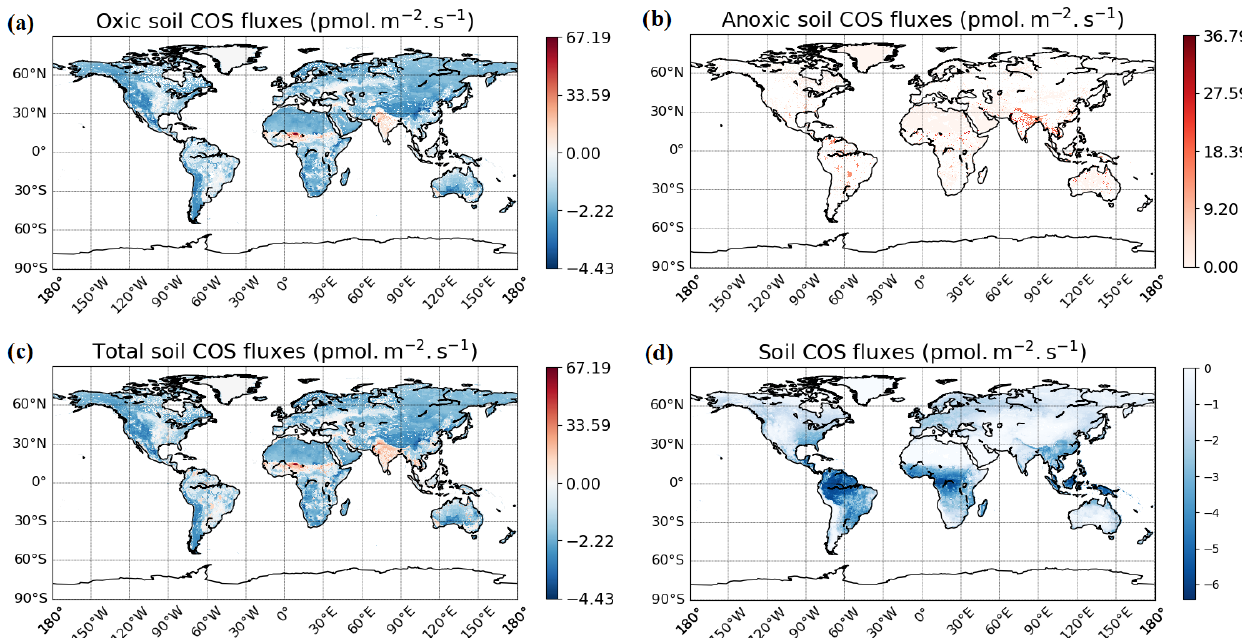
Figure 7. Maps of mean soil COS fluxes for the mechanistic (a, b, c) and the empirical model (d) , computed over 2010–2019 with a variable atmospheric COS concentration. Colour scales were normalized between the minimum and maximum soil COS flux values and centred on zero for oxic and total soil COS fluxes computed with the mechanistic model. The map resolution is 0.5 ◦ × 0.5 ◦